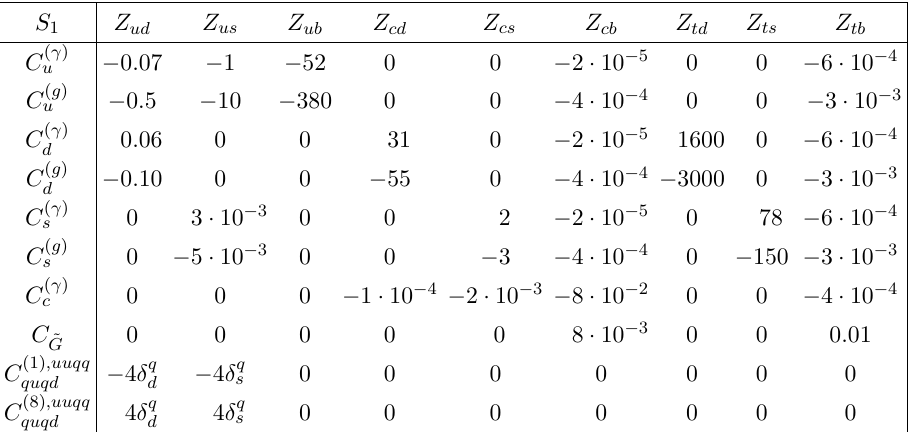
Table 2 . Dependence of the low-energy CP-odd Wilson coe(cid:14)cients in eqs. (3.1) and (3.20) on the Z qq 0 couplings for m LQ = 1 TeV. All low-energy couplings were evaluated at (cid:22) = 1 GeV apart from C ( (cid:13) ) c which was evaluated at (cid:22) = m c